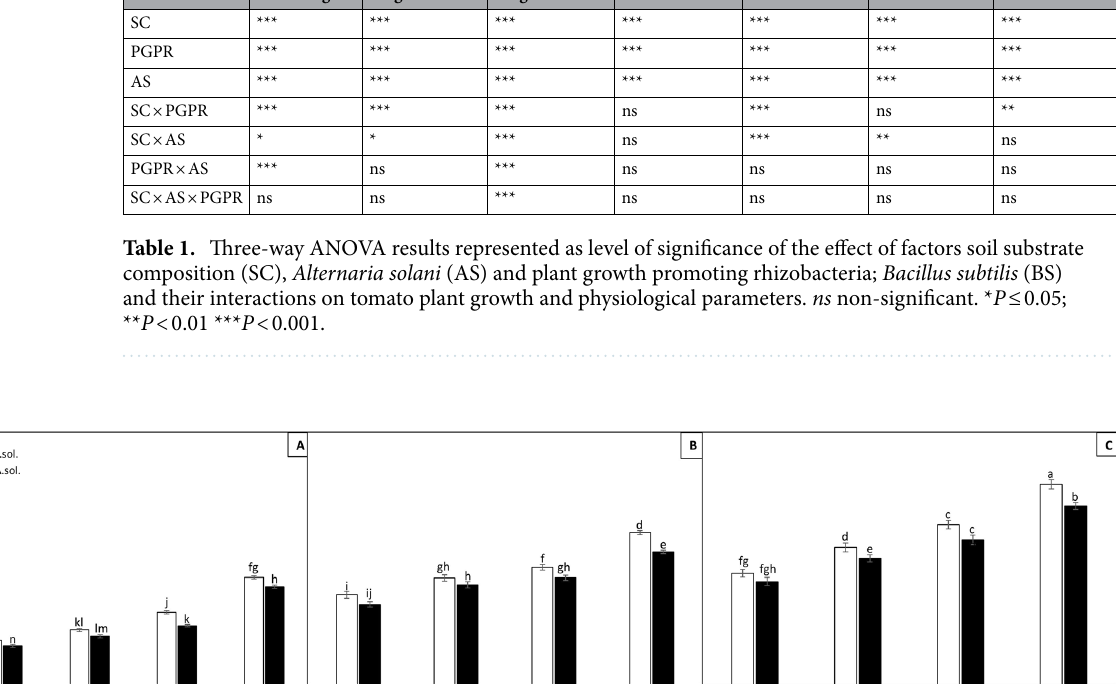
Dry root weight